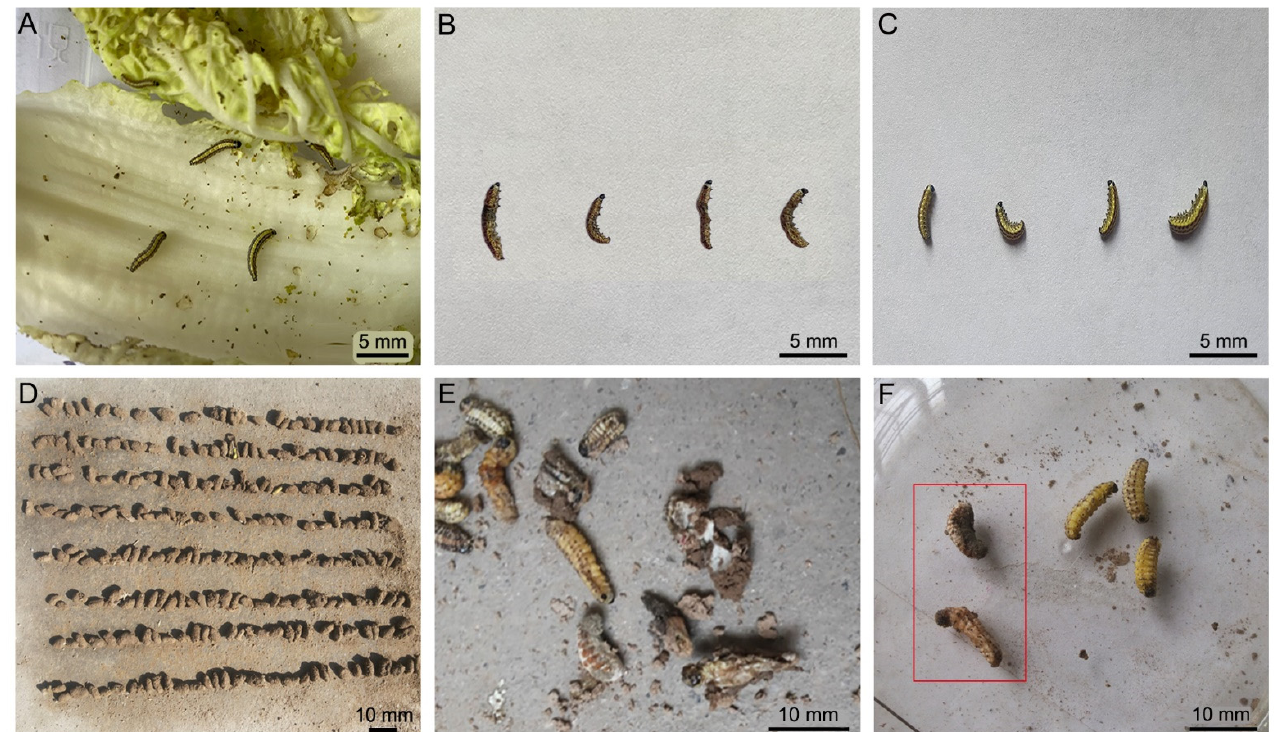
Figure 1. ( A ) Healthy larvae with uniform body color; ( B ) The bodies of dead third-instar larvae poisoned by INA bacteria; ( C ) The dead control larvae under natural condition; ( D ) Cocoons treated with INA bacteria before buried in the soil; ( E ) Overwintering larvae from the cocoons removed from the ground; ( F ) Dead overwintering larvae poisoned by INA bacteria as shown in a red box and dead control samples.